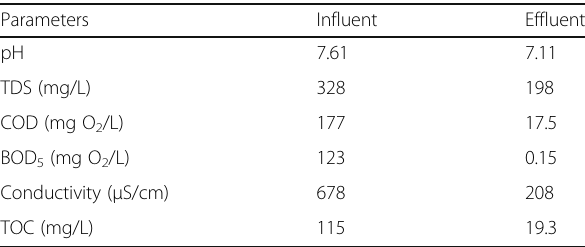
Table 1 Physical-chemical parameters of influent and effluent